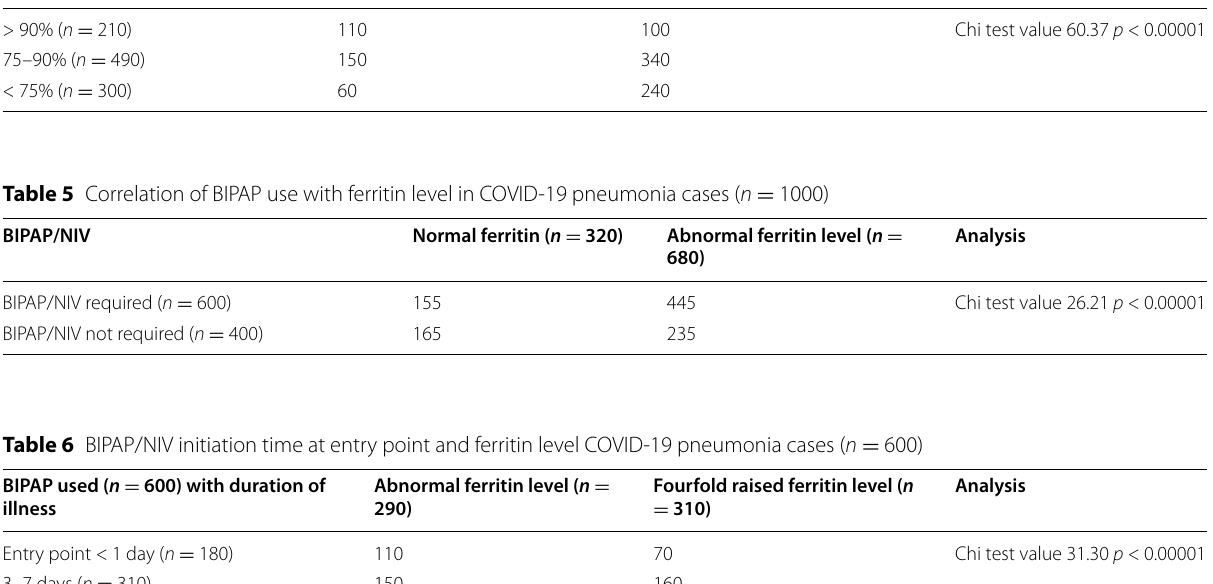
Table 4 Oxygen saturation at entry point and ferritin level in COVID-19 pneumonia cases ( n Oxygen saturation